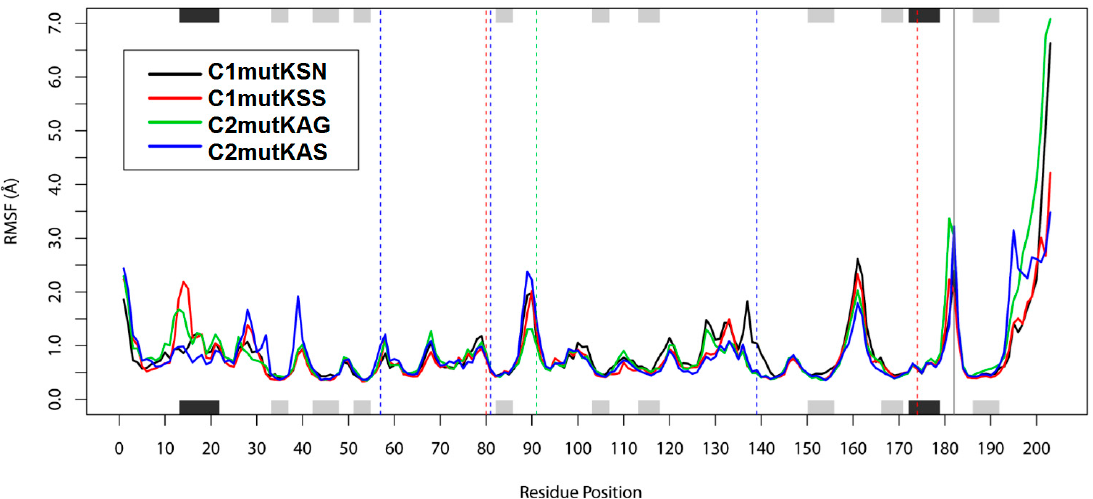
Figure 4. Root-mean-square fluctuation (RMSF) values. The positions of helices (black) and strands (grey) are indicated on the top and bottom axes of the fluctuation plot. Dashed vertical lines indicate residues 80 and 174 (red), 91 (green), and catalytic residues 57, 81, and 139 (blue).